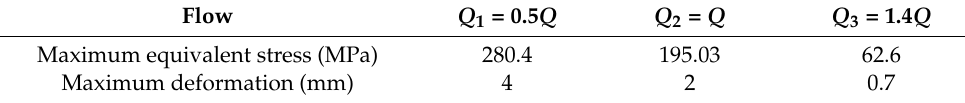
Figure 19. Q = 28 m 3 /s Deformation of impeller, Unit: m.